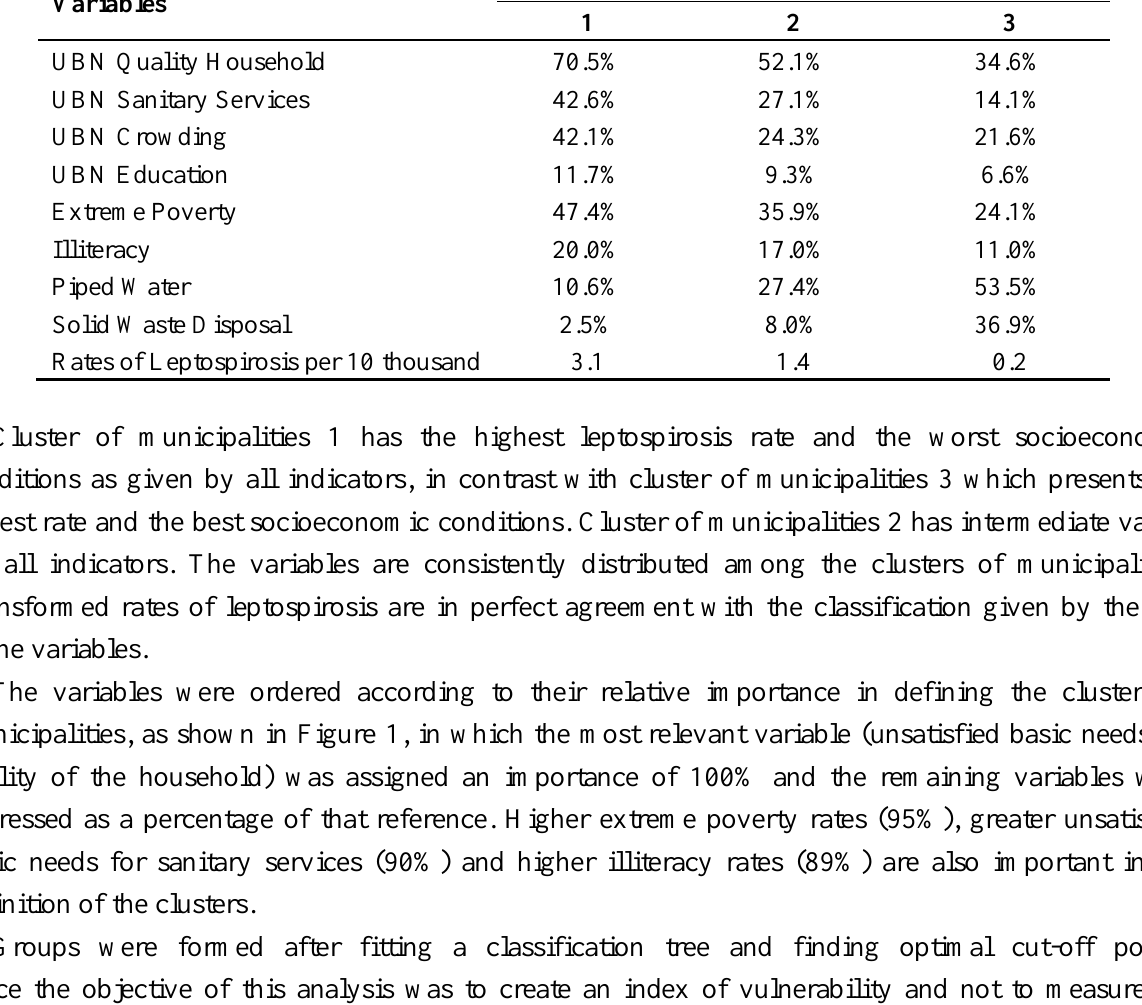
Table 4. Characterization and validation of clusters of municipalities (mean values).